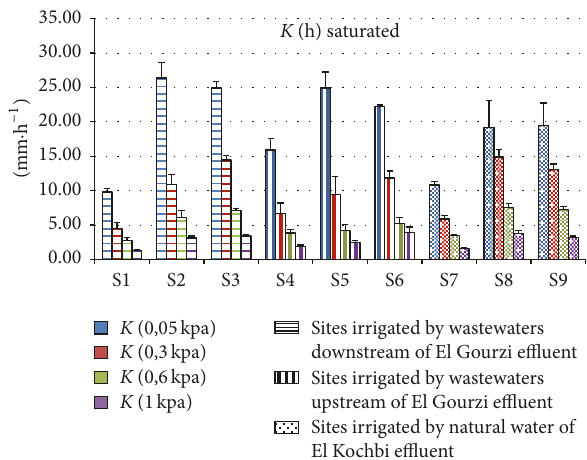
Figure4:Saturatedhydraulicconductivityaverageatdifferentwater potential in study